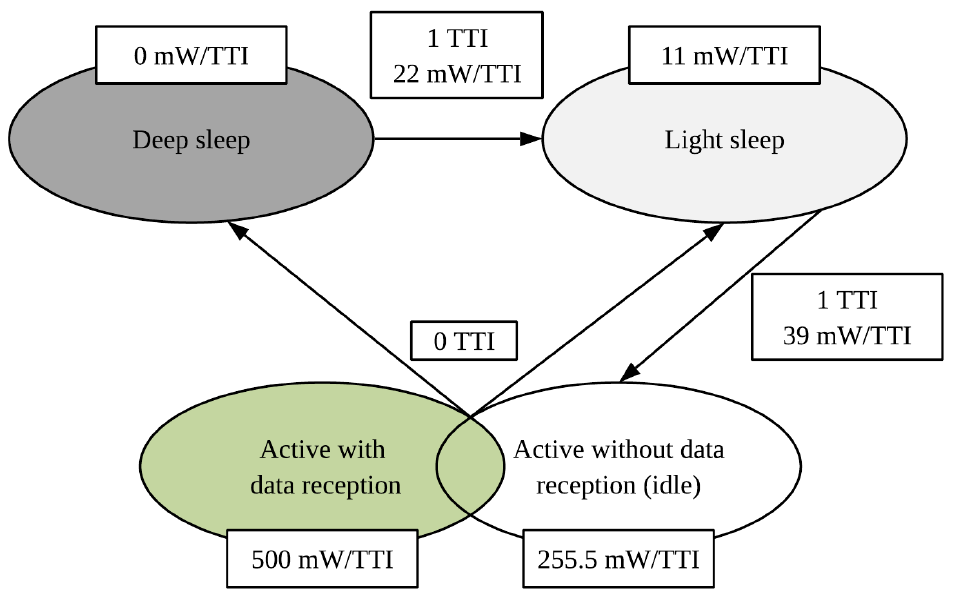
Figure 8. UE power consumption